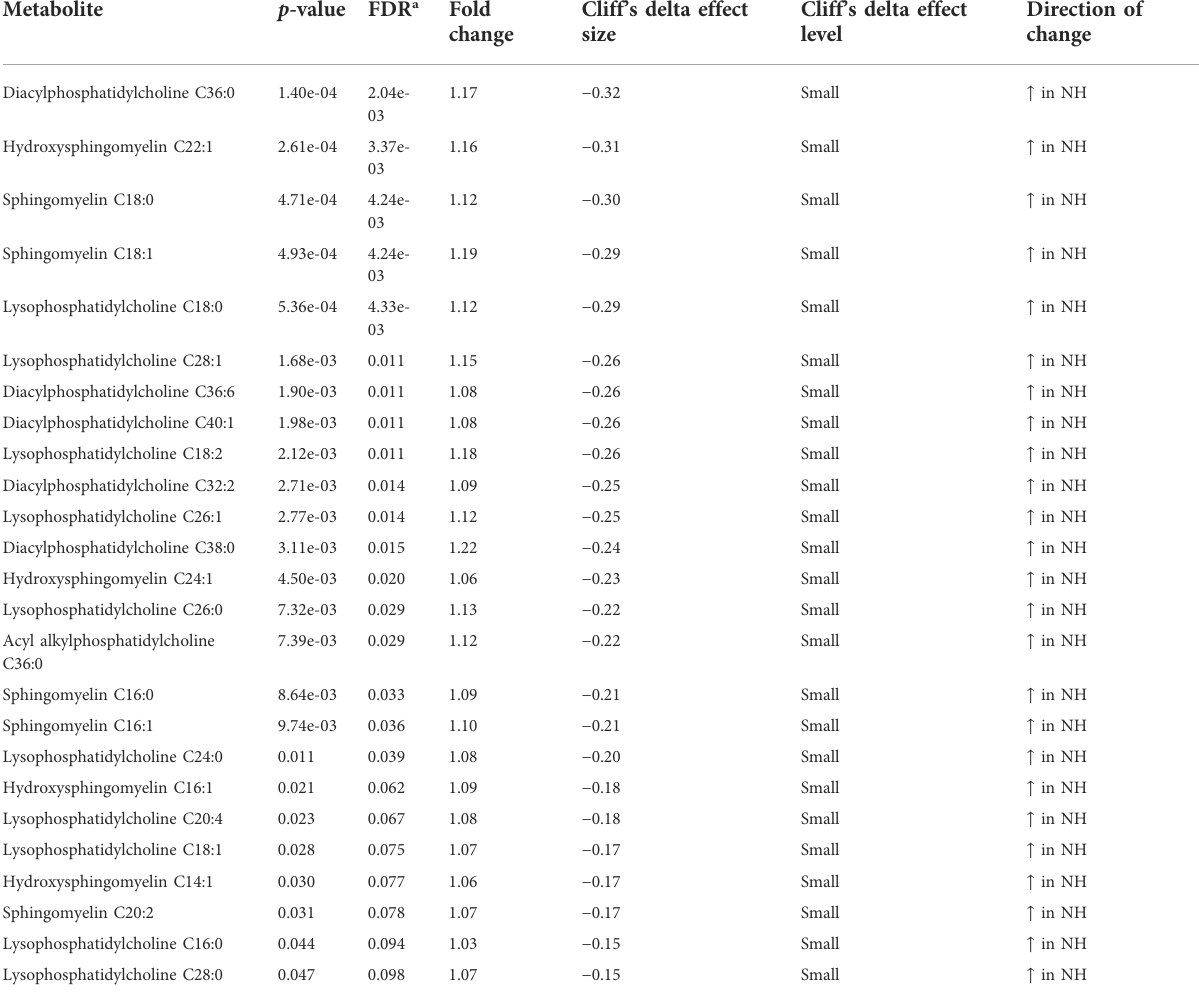
TABLE 2 Phosphatidylcholines and sphingomyelins signi fi cantly ( p < 0.05) affected by treatment (H = Habituated; NH = Non-habituated) in goats.